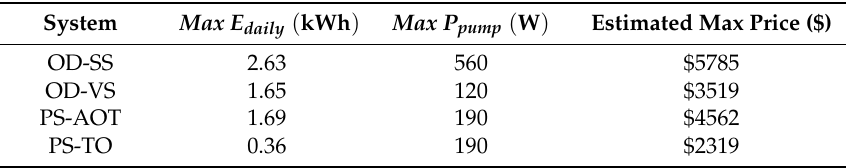
Table 12. Estimated Maximum Price per System using Equation (15).